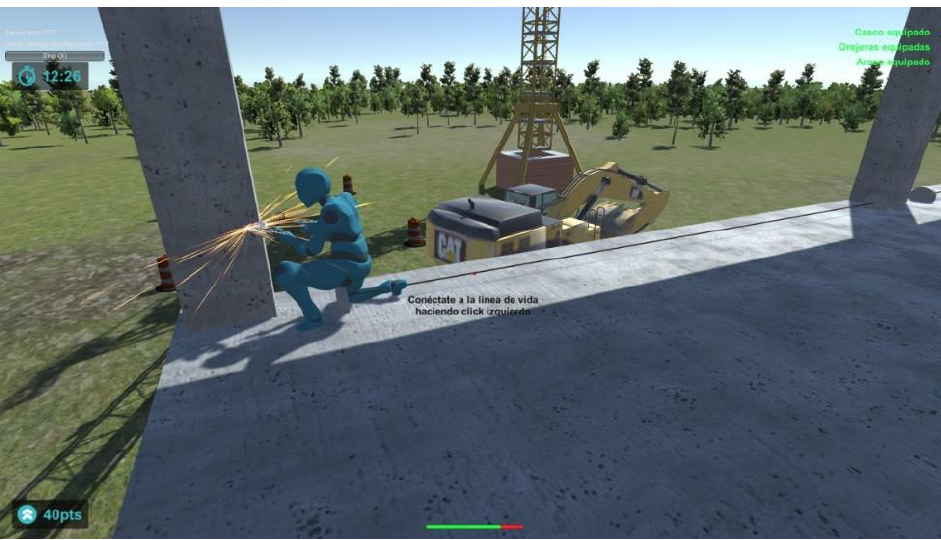
Figure 14. Worker and machinery as interactive and animated parts of the stage to consider.